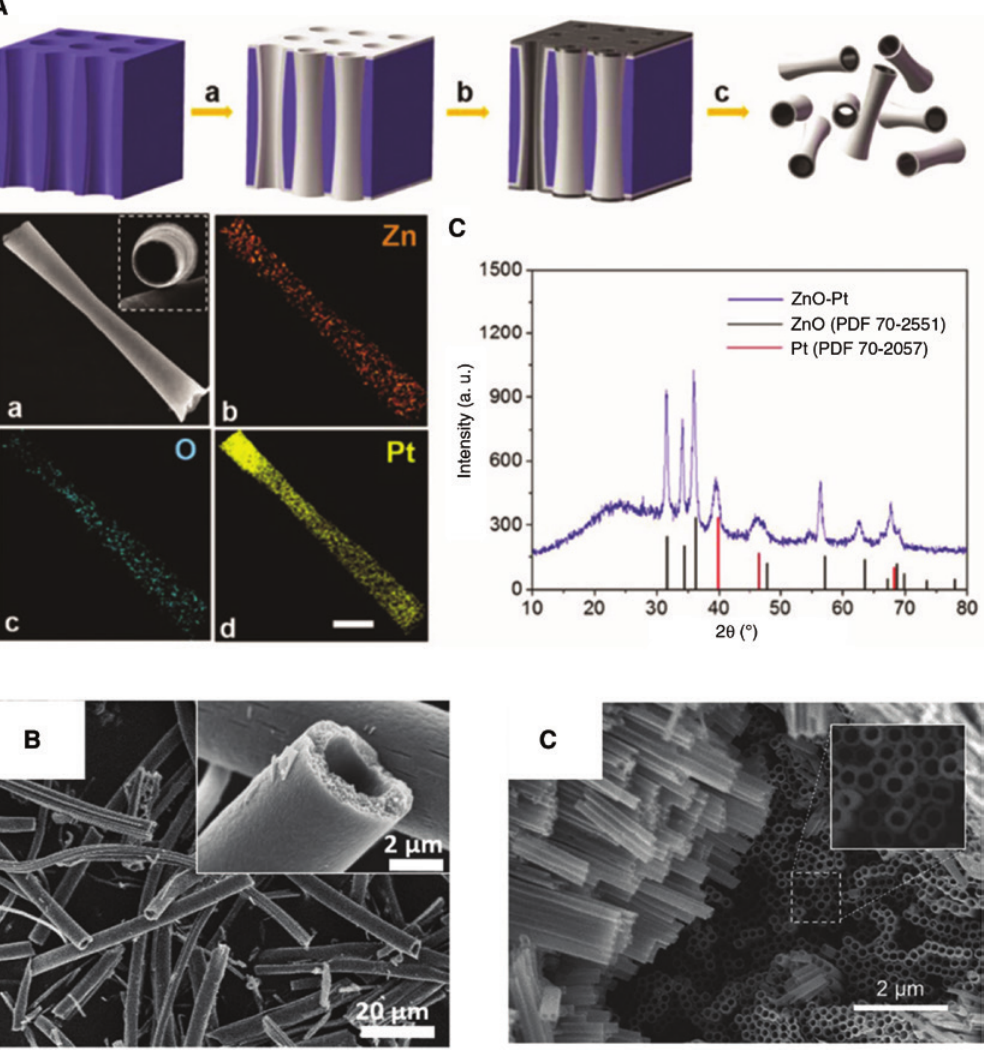
Figure 9: Various nanotubular structures of light-driven micro/nanomotors. (A) Preparation procedures of ZnO/Pt microrockets using polycarbonate membrane templates and the SEM image of ZnO/Pt microrocket [107]. Copyright 2017, The Royal Society of